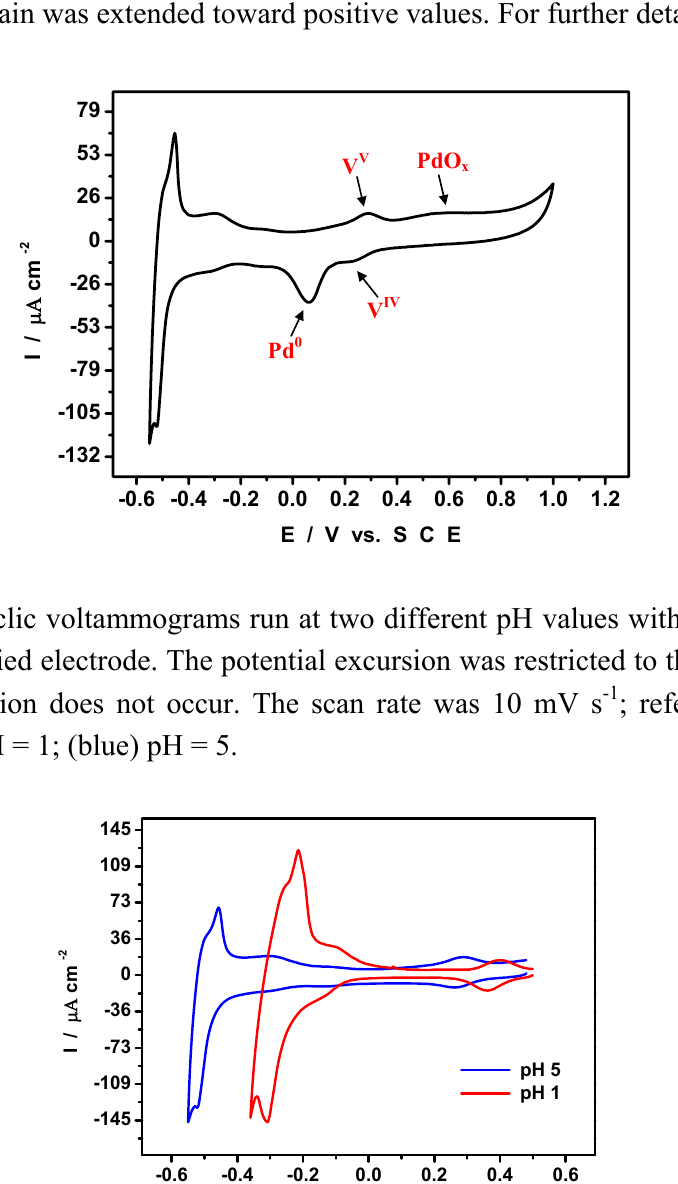
Figure 5. Cyclic voltammograms run in a pH = 5 medium with a Pd 0 @POM glassy carbon-modified electrode. The reference electrode was SCE. Compared to Figure 2A, the potential domain was extended toward positive values. For further details, see text.